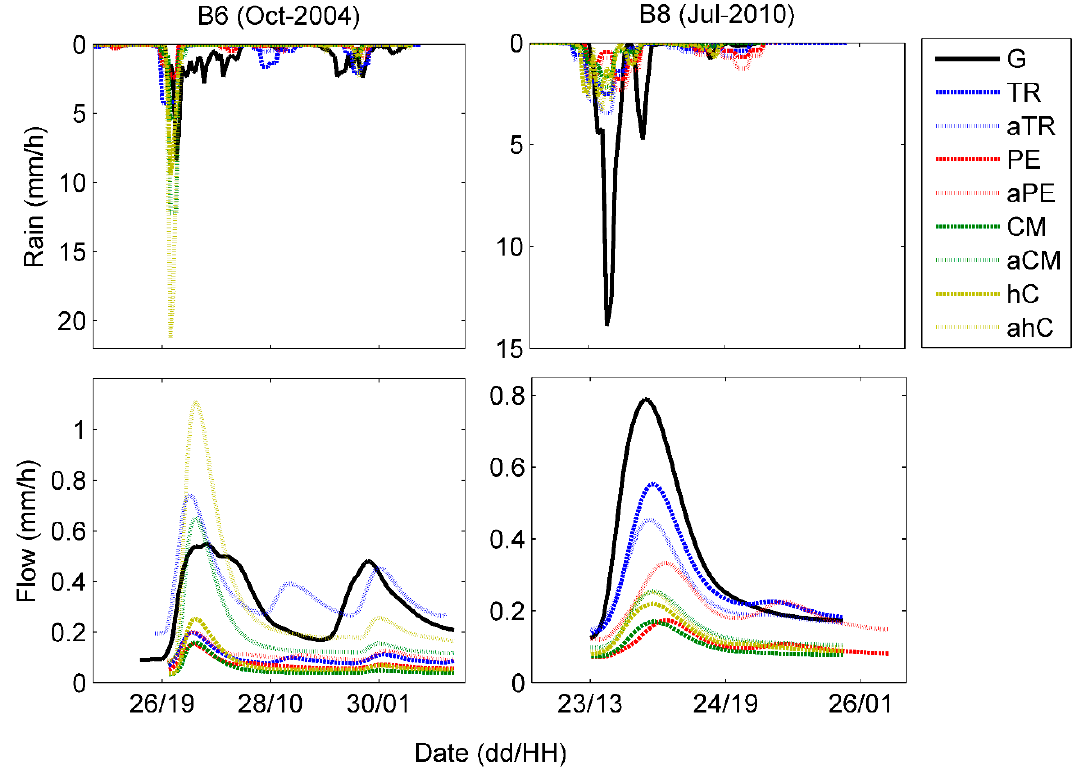
Figure 2. Example of two matched rainfall-runoff events for basins with ID 6 ( left ) and 8 ( right ). Basin-averaged rainfall time series ( top ) and simulated hydrographs ( bottom ) are shown for all precipitation products used.